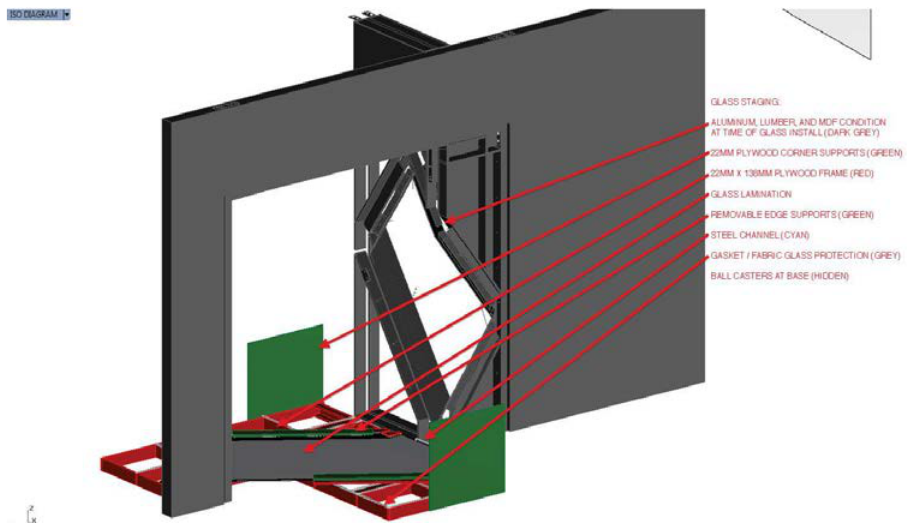
Fig. 24 33-D, 2014 | Glass installation sequencing Rendering courtesy of Sarah Oppenheimer